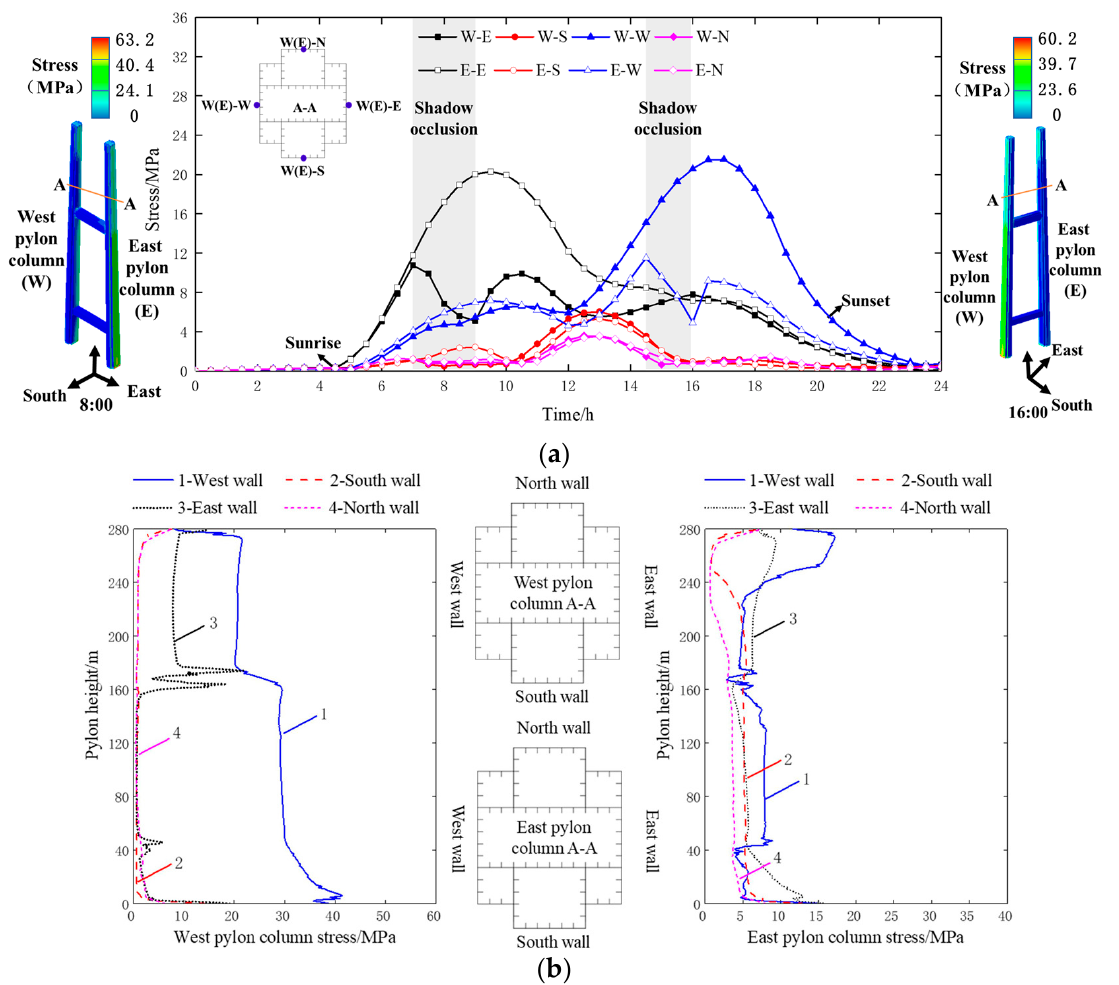
Figure 17. Stress curve of pylon in summer: ( a ) Thermal stress curve of cross-section A-A; ( b ) Vertical stress distribution of bridge pylon at 16:00.